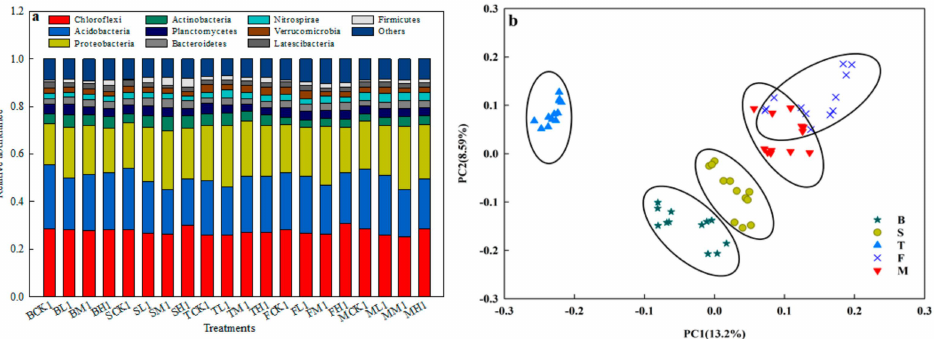
Figure 6. Relative abundance of bacterial taxa at the phylum level ( a ) and PCA plot of soil bacterial community distribution ( b ) under different fertilization treatments during the different rice growth stages. Note: CK: chemical fertilizer, CL: the low amount of CMV, CM: the medium amount of CMV, CH: the high amount of CMV, B: background soil, S: seedling stage, T: tillering stage, F: flowering stage, M: maturity